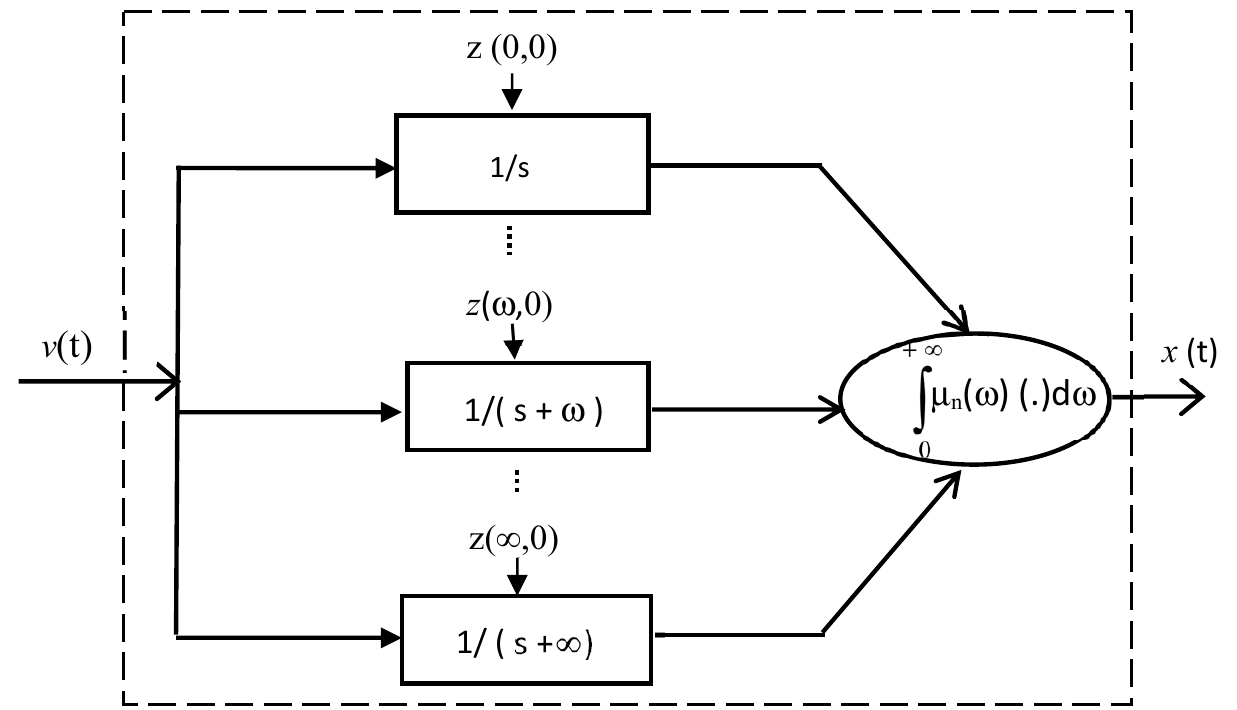
Figure 1. The frequency-distributed model of the fractional integrator.